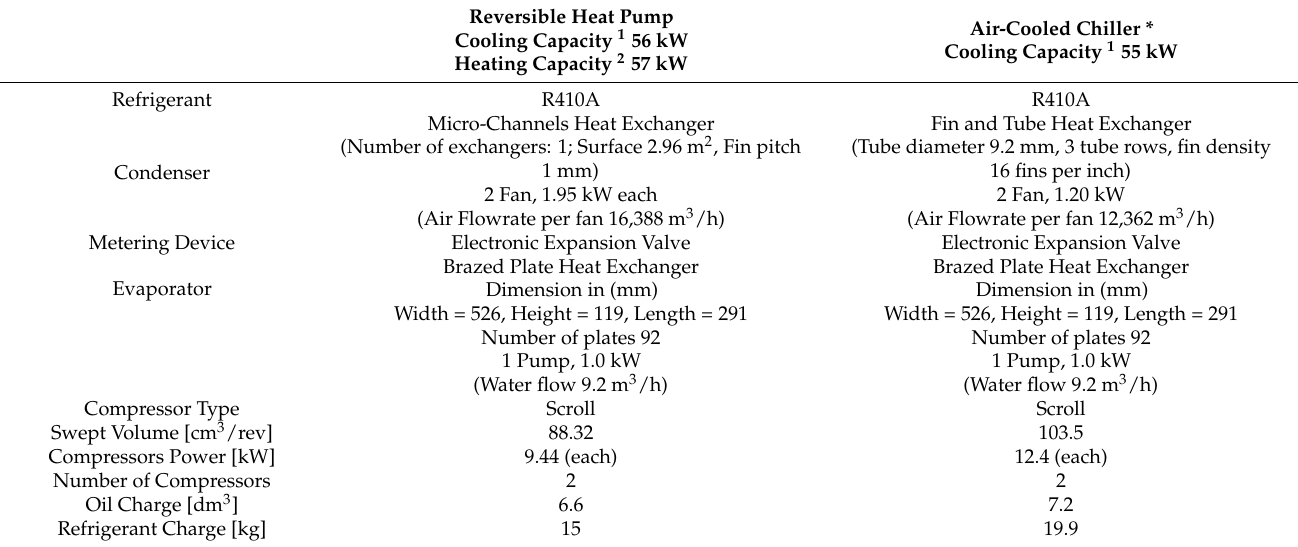
Table 1. Main technical features of the air-cooled vapour compression chillers and reversible heat pump.